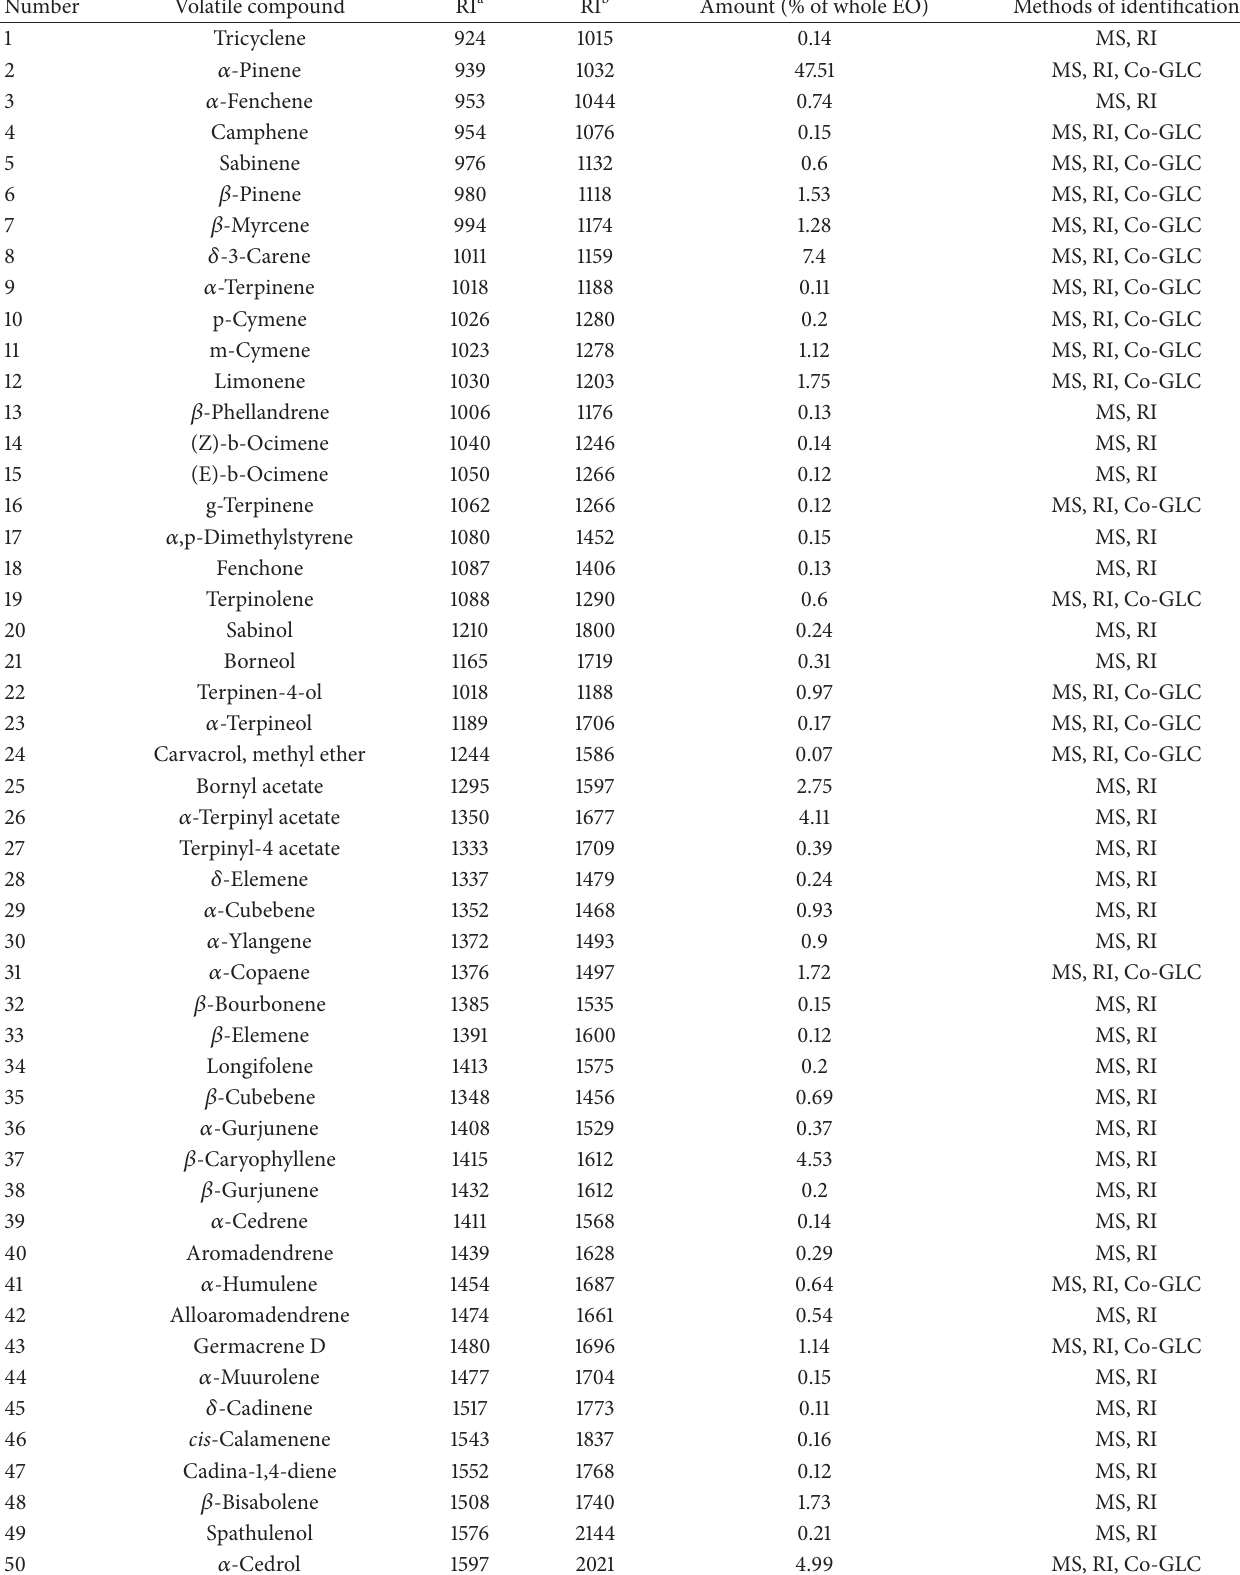
Table 1: Essential oil composition from cones of Cupressus sempervirens